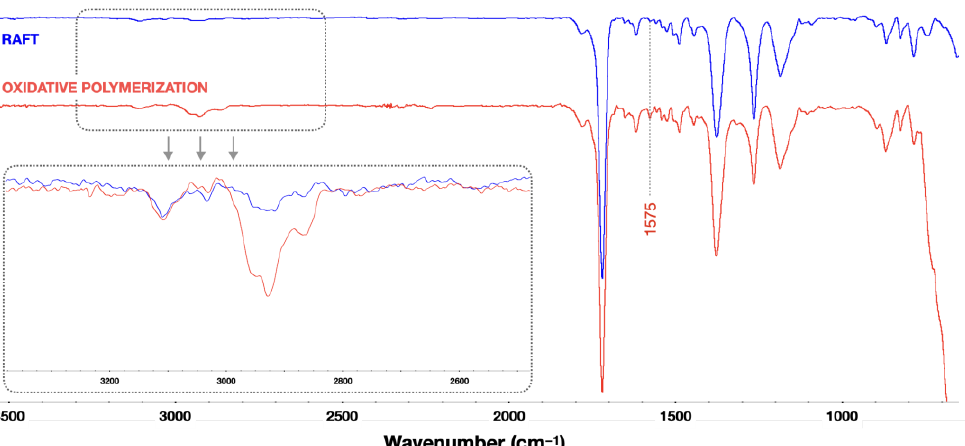
Figure 6. IR transmittance spectra of poly( St-D - alt - Ma-A ) brushes obtained via RAFT before and after self-templating oxidative polymerization.